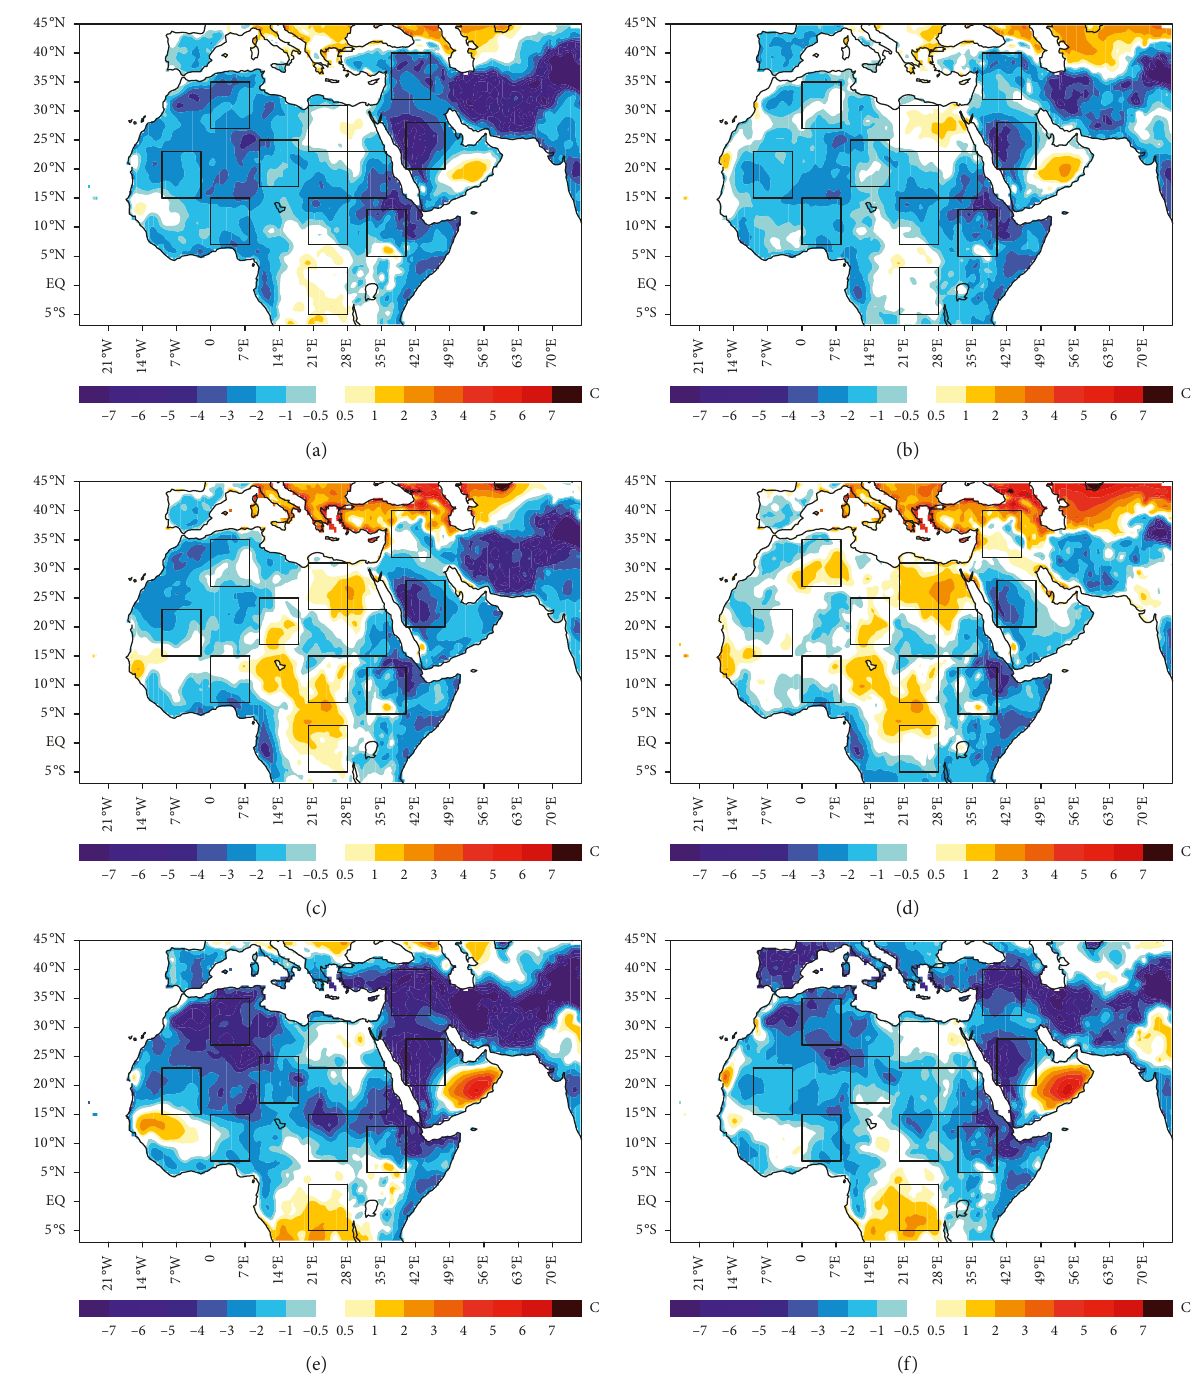
Figure 3: Spatial distribution of air temperature bias (in ° C) with respect to CRU data for (a) annual RegCM4-HadGEM2, (b) annual RegCM4-ECHAM6, (c) winter RegCM4-HadGEM2, (d) winter RegCM4-ECHAM6, (e) summer RegCM4-HadGEM2, and (f) summer RegCM4-ECHAM6 averaged over the common period